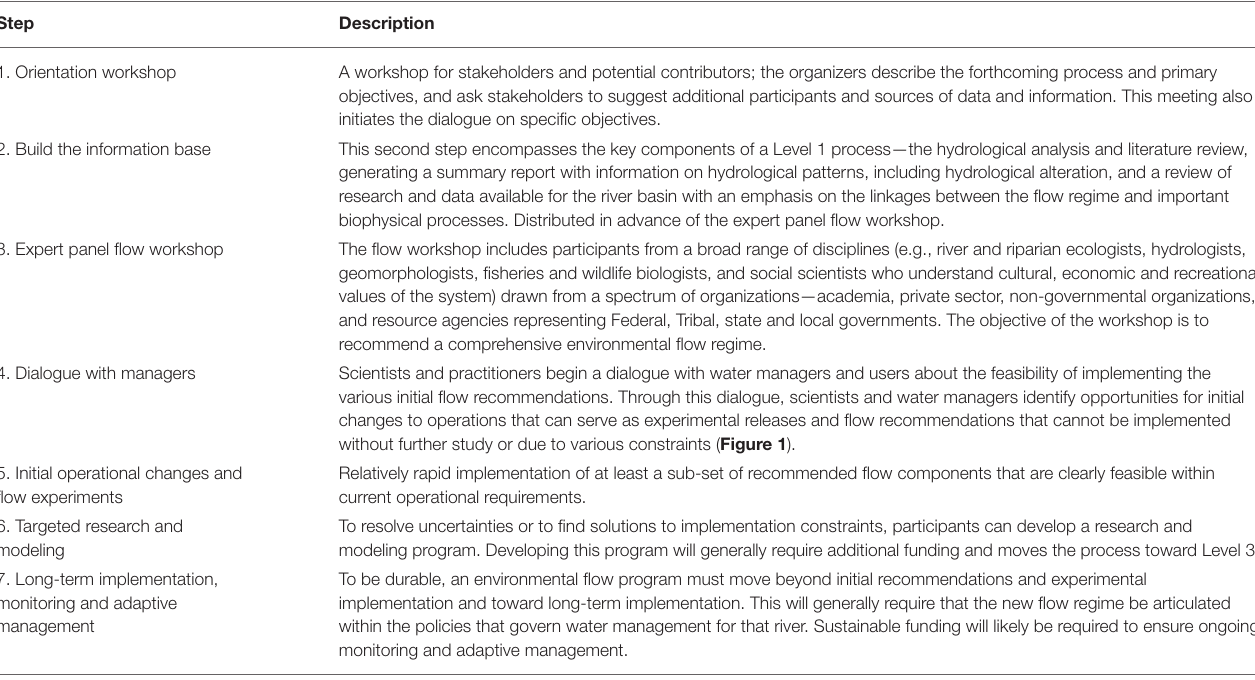
TABLE 2 | Steps in a level 2